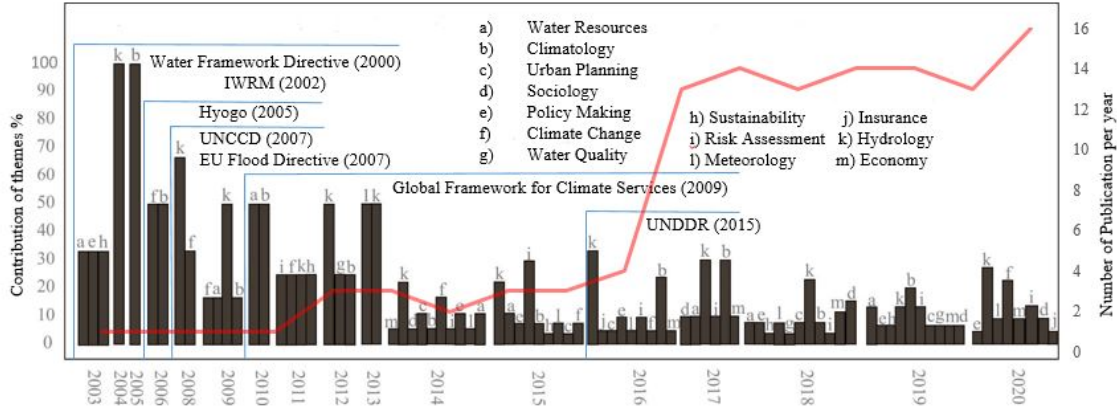
Figure 2. Publication year of research material database around the subject of flood and drought from 2003 to 2020 (red line shows the number of publications).